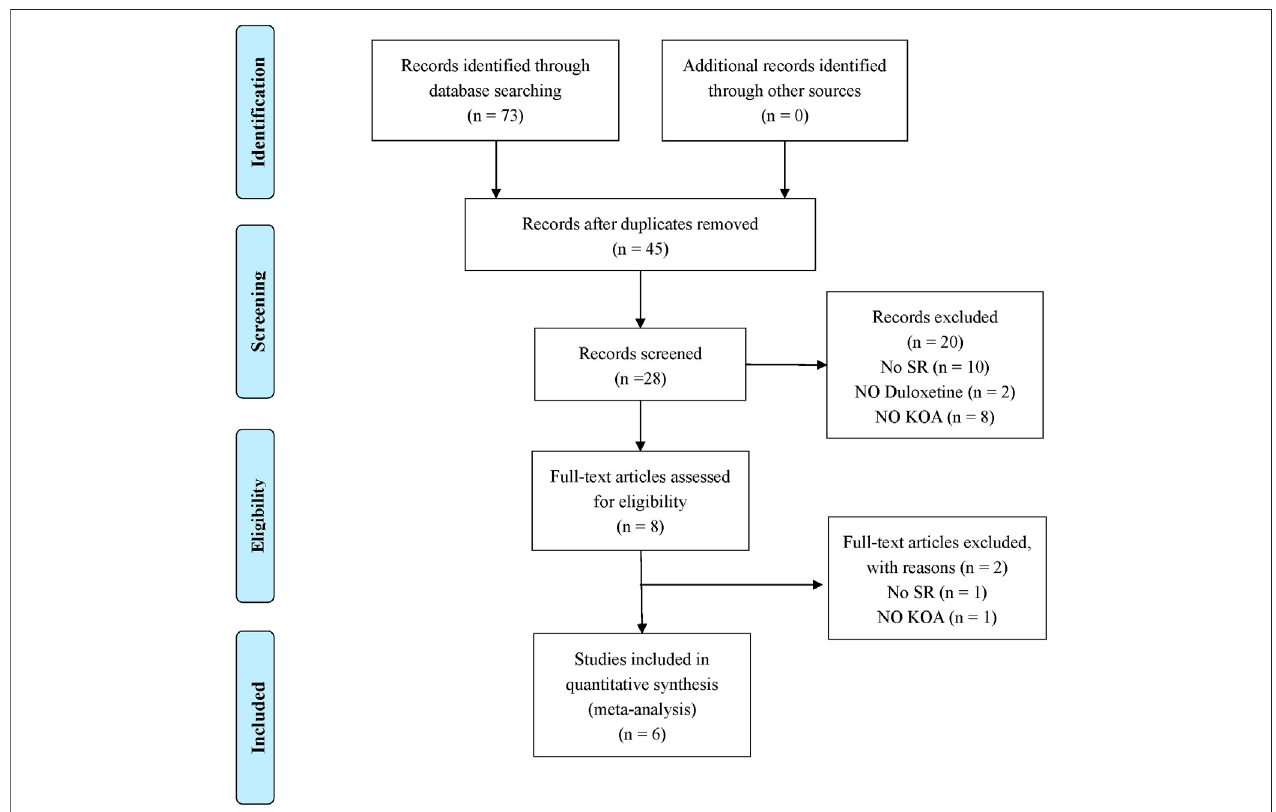
FIGURE 1 | Literature selection